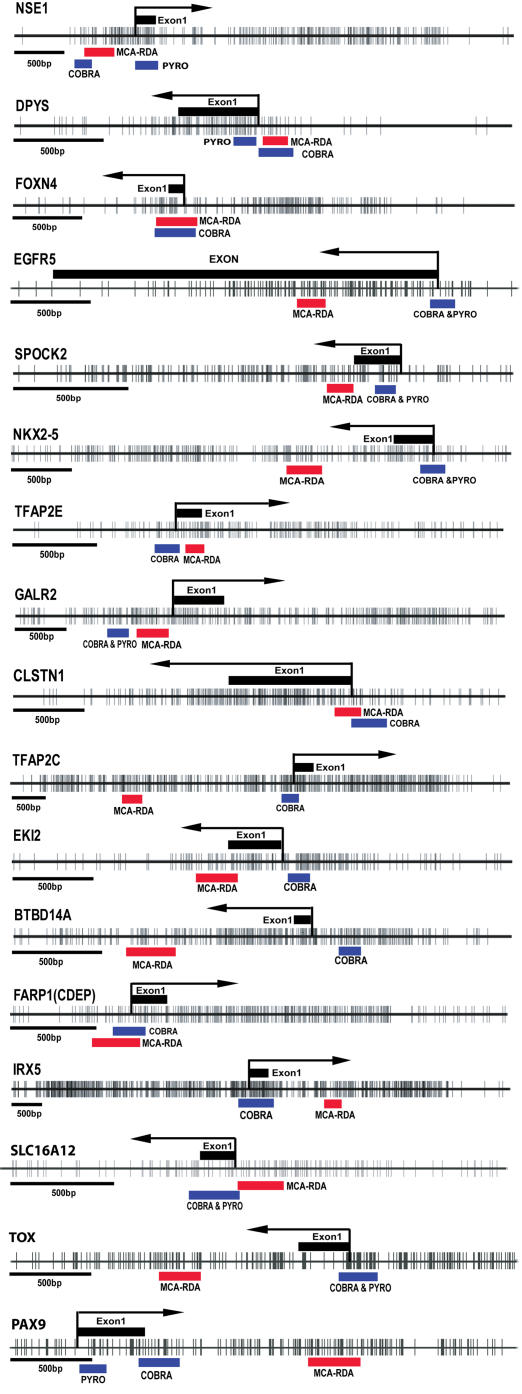
CpG island map and DNA methylation status of identified clones.CpG maps of the seventeen genes analyzed in this study. For each gene, short vertical bars indicate CpG sites. Exon1 is indicated by black rectangles at the top, whereas location of the MCA-RDA clones is indicated by red rectangles at the bottom. Arrows point to known or presumed transcription start sites. Blue bars at the bottom indicate areas that analyzed by COBRA or pyrosequencing.